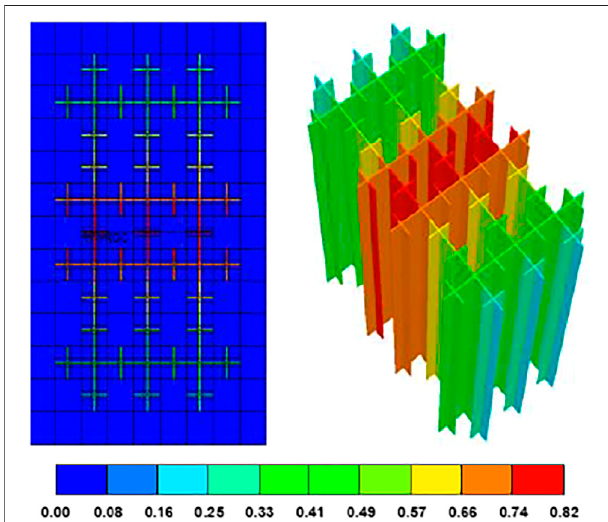
FIGURE 5 | Permeability distribution of hydraulic fractures in fracturing